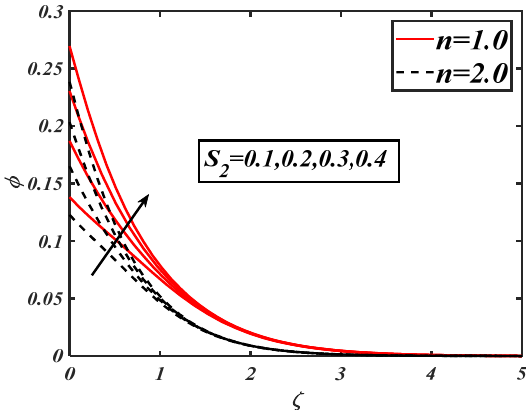
Figure 20. Figure 20. S 2 illustration against φ . Figure 20.